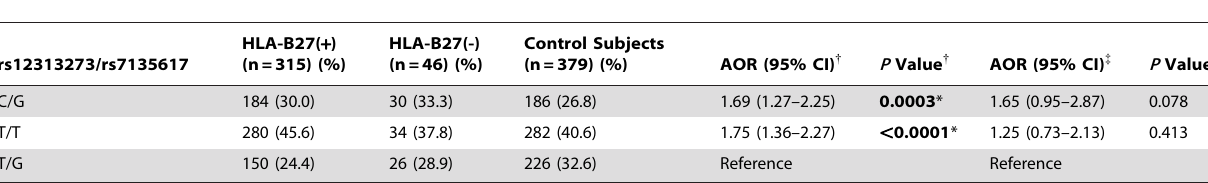
Table 4. Haplotype frequency of the ORAI1 gene in HLA-B27( + ) or HLA-B27(-) patients with ankylosing spondylitis and